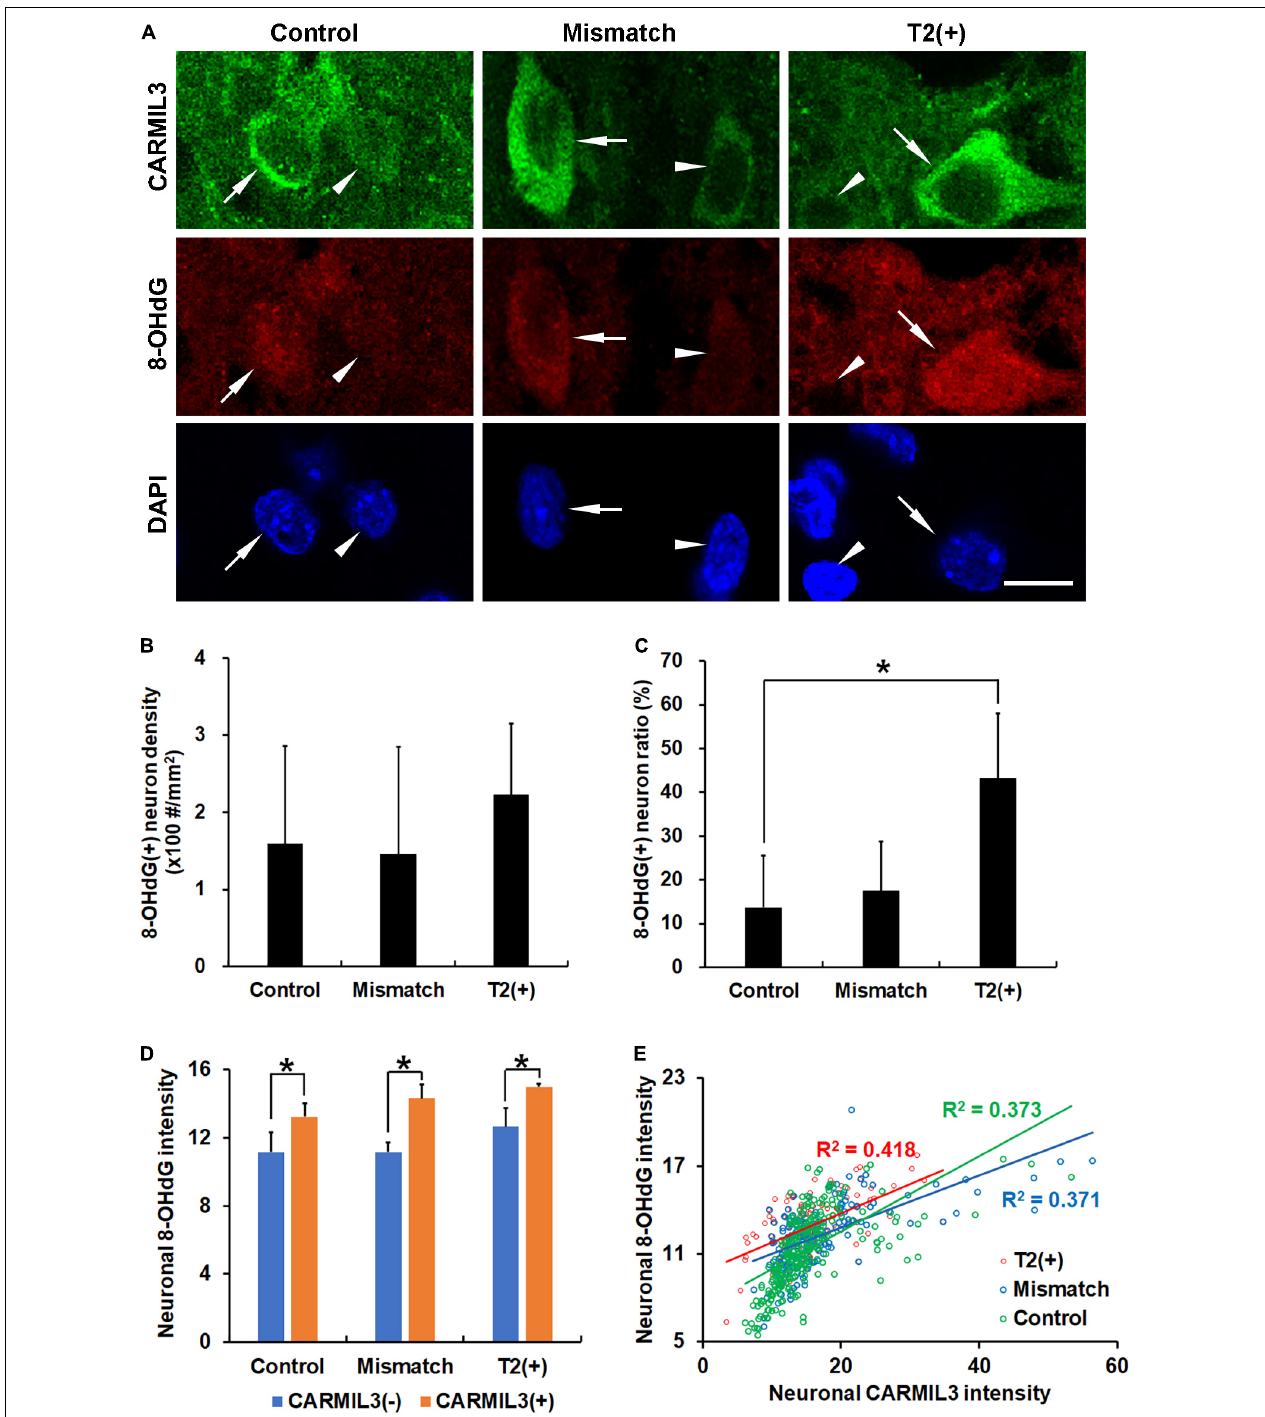
FIGURE 8 | Association of CARMIL3 with oxidative stress. (A) Representative images of double-labeling for CARMIL3 and 8-OHdG in the T2(+), mismatch, and control regions. CARMIL3(+) neurons (arrows) tended to have higher 8-OHdG intensity than CARMIL3( − ) neurons (arrowheads). (B,C) 8-OHdG(+) neuron density (B) and 8-OHdG(+) neuron ratio [the number of 8-OHdG(+) neurons divided by total number of neurons] (C) in these three regions. The 8-OHdG(+) neuron ratios were significantly different among the three regions ( p = 0.027). 8-OHdG(+) neuron ratios, but not densities, were higher in the T2(+) areas than in the contralateral areas (* p < 0.05). (D) Quantitative comparison of neuronal 8-OHdG intensity between CARMIL3(+) and CARMIL3( − ) neurons. CARMIL3(+) neurons had higher 8-OHdG intensities than CARMIL3( − ) neurons in all three regions (all p < 0.05). (E) Correlation between 8-OHdG and CARMIL3 intensities of all neurons in one image of each region in four rats. There were significant associations between neuronal 8-OHdG and CARMIL3 intensities in all three regions (all p < 0.001). There was a significant difference in the regression slopes between the mismatch and control regions ( p = 0.003). Scale bar = 10 µ m.